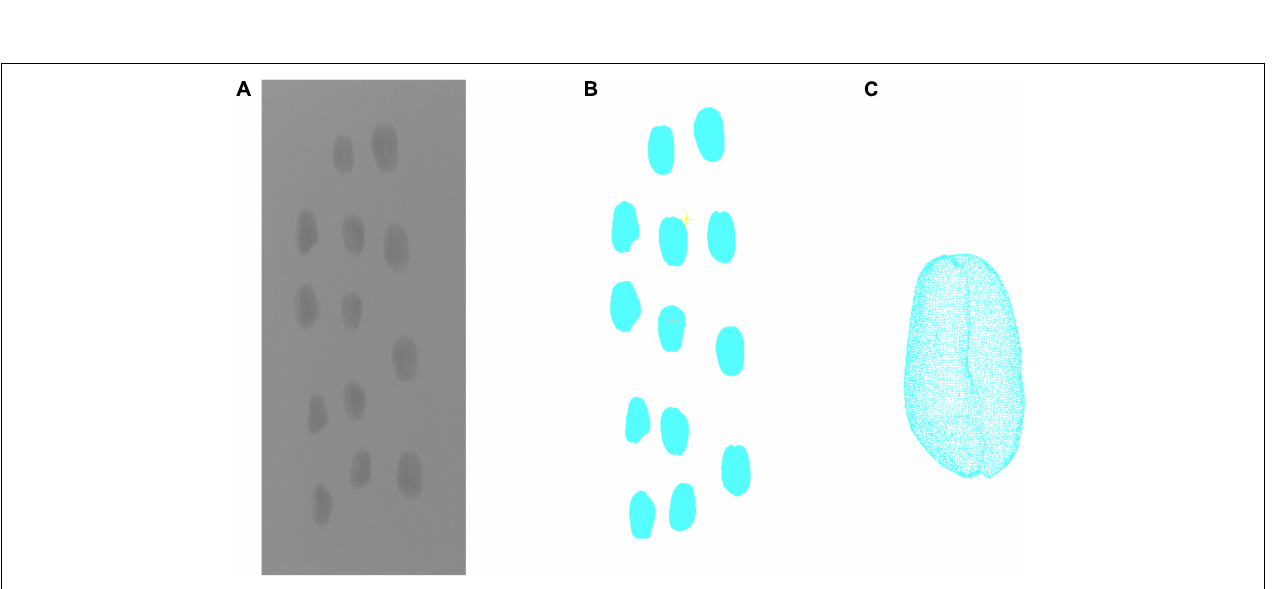
FIGURE 3 | X-ray CT 3D reconstruction of wheat grains. (A) Projected image. (B) 3D reconstruction result. (C) Single grain point clouds.